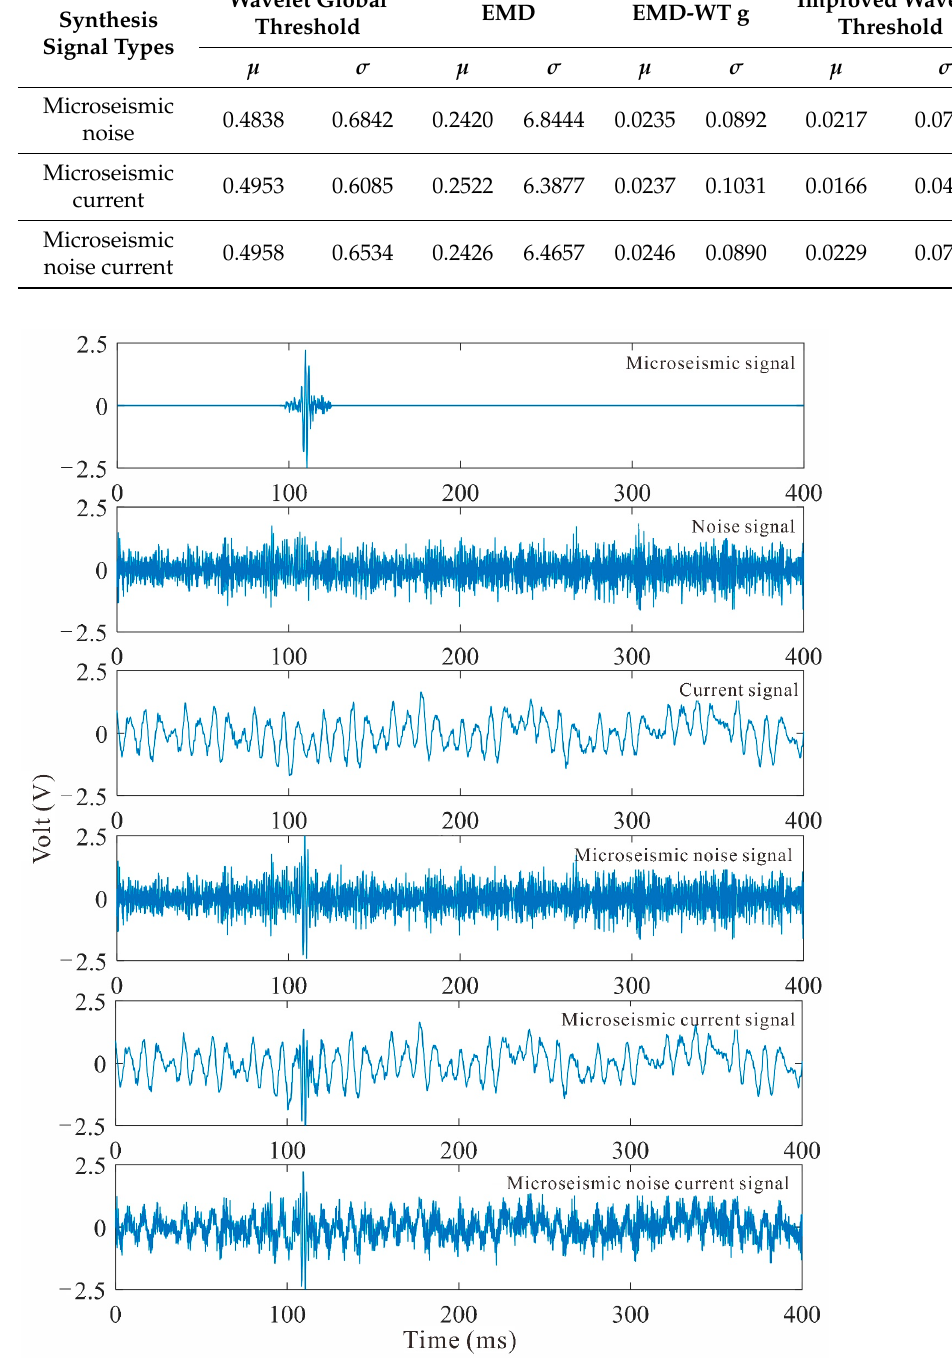
Figure 4. Synthesized signal with microseismic, noise and current.